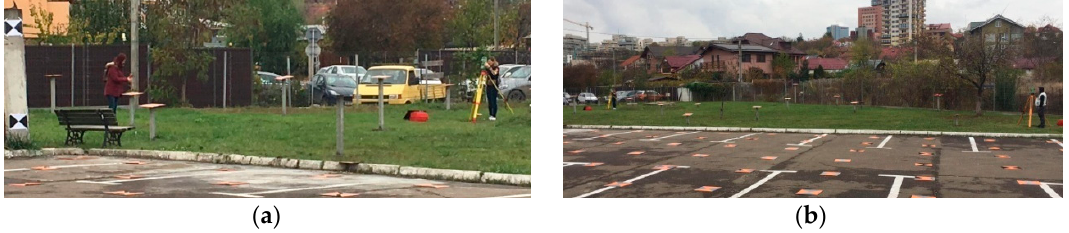
Figure 5. ( a ) Taking the measurements using a miniprism and ( b ) two Leica TCR 405 total stations, centered on A and B GNSS points. centered on A and B GNSS points.